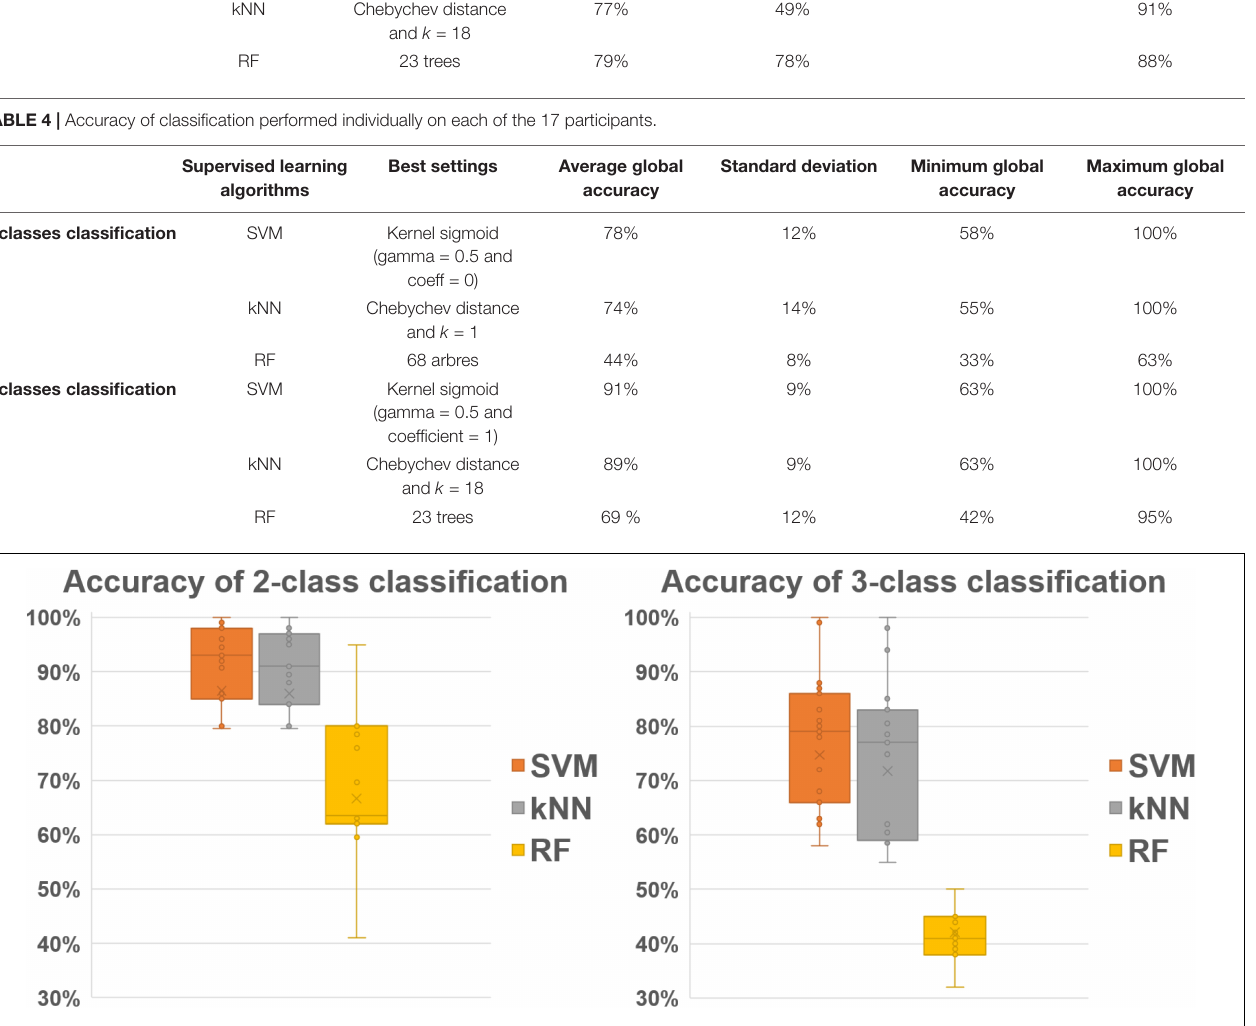
FIGURE 3 | Bar and whisker plot for individual 2-class (left) and 3-class (right) OFS